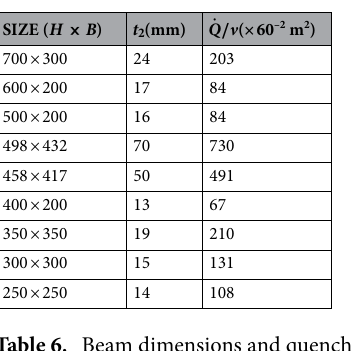
Table 6. Beam dimensions and quenching parameters.